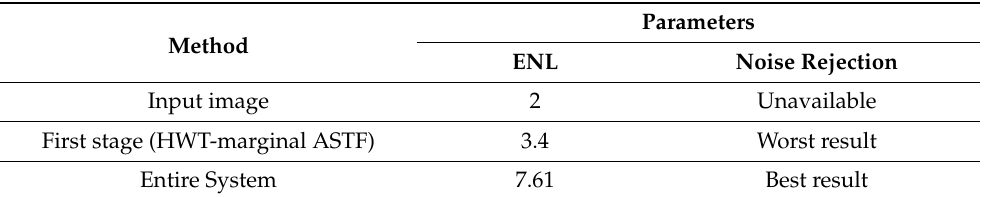
Table 6. Comparison of components performance in the two-stage denoising system proposed in terms of ENL.